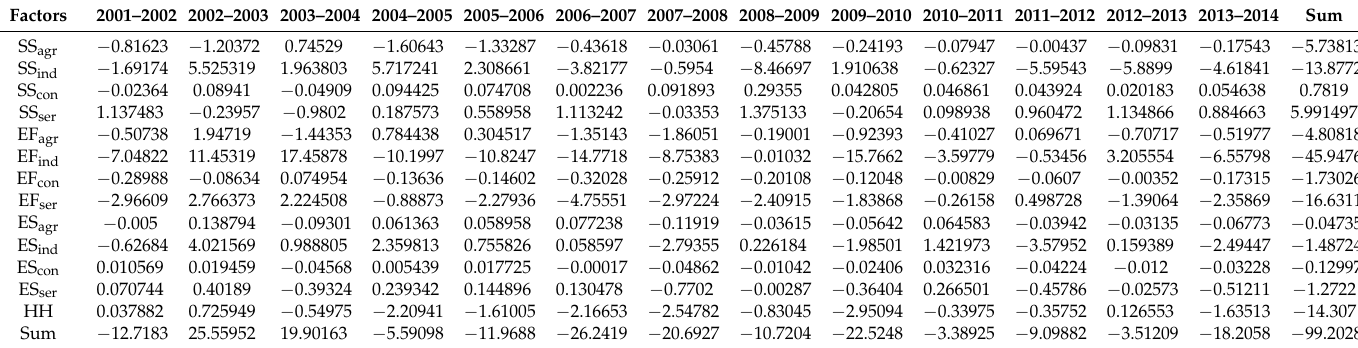
Table 2. Annual Contributions of Selected Primary Factors (Unit: MT/Trillion Yuan).